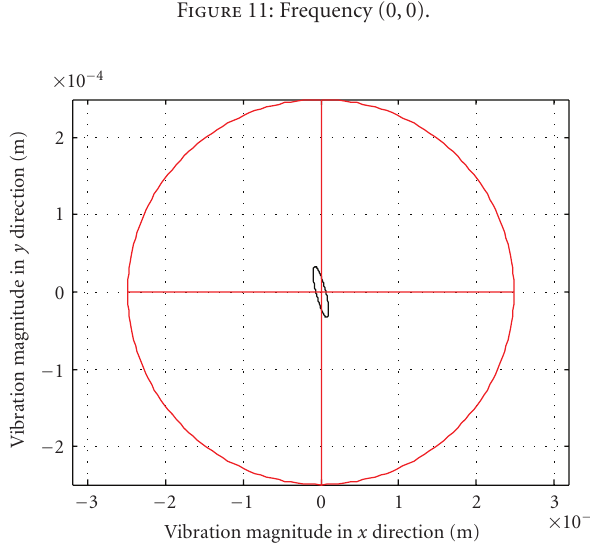
Figure 12: Shaft orbit